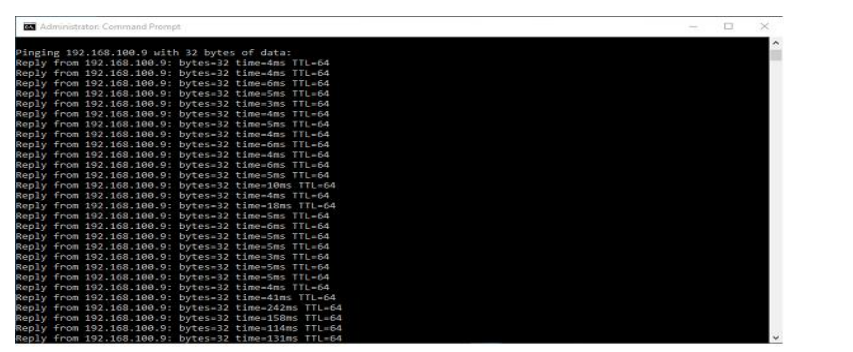
Figure 4 – Checking the availability of the targeted computer using the ping command Рис . 4 – Проверка доступности целевого компьютера с помощью команды ping Слика 4 – Провера доступности циљаног рачунара употребом ping